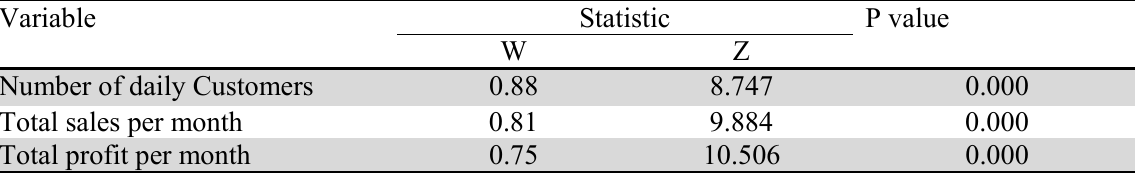
Shapiro-Wilk W test for